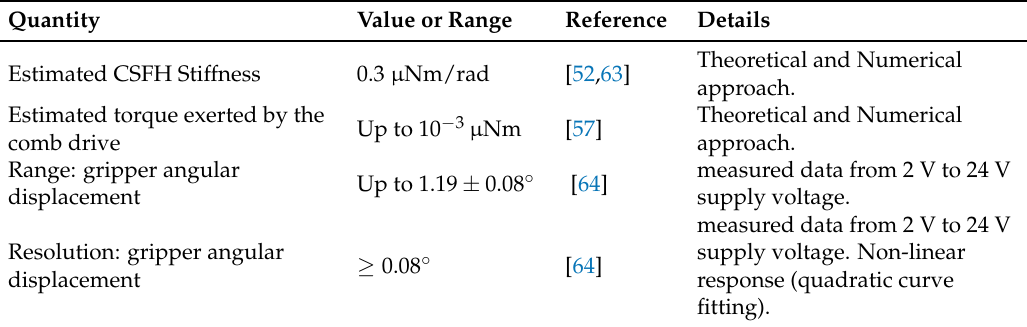
Table 2. Operational characteristics of the adopted